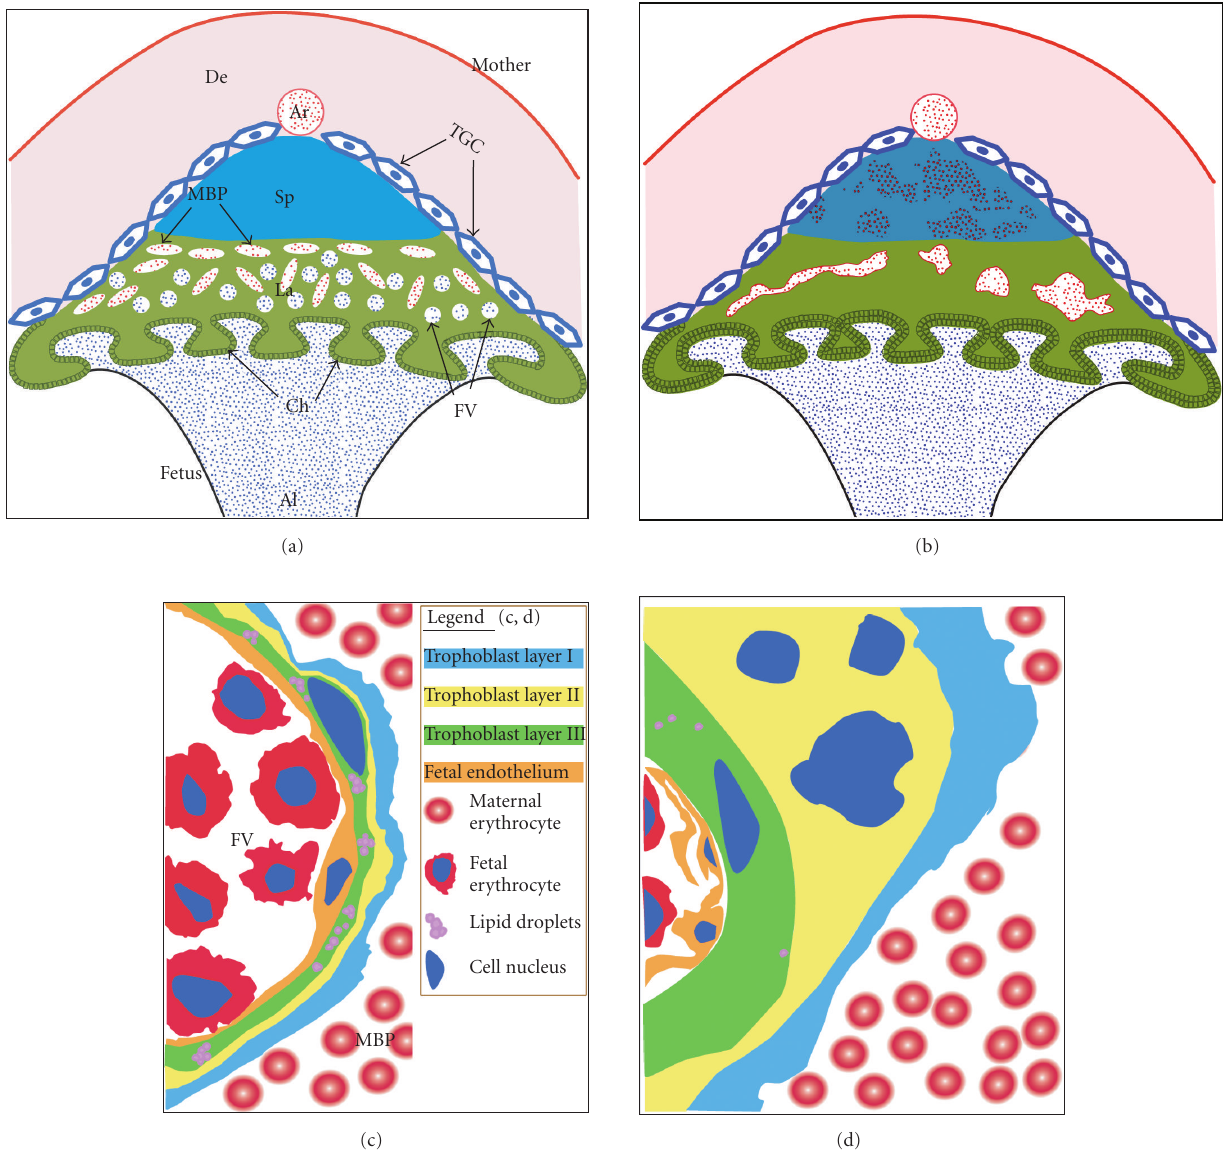
Figure 2: Schematic representation of the Pparg -null phenotype. (a) WT placenta. Al: allantois; Ar: maternal artery; Ch: chorion; De: de- cidua; FV: fetal blood vessels; La: labyrinth; MBP: maternal blood pools; Sp: spongiotrophoblast; TGC: trophoblast giant cells. (b) Pparg -null placenta. Corresponding structures are as in (a). Di ff erences of note are marked erythrophagocytosis by spongiotrophoblast cells (red speck- les), absence of fetal vessels and breakdown of the maternal blood pools in the labyrinth, and thickening of the chorion. (c,d) Ultrastructural features of WT and Pparg -null hemochorial barriers (based on [12]). See legend in (c) for identity of major features. Di ff erences include thickening of the three trophoblast layers, near elimination of lipid droplets in layer III, and loosening of the tight adherence between the trophoblast (green) and fetal endothelium